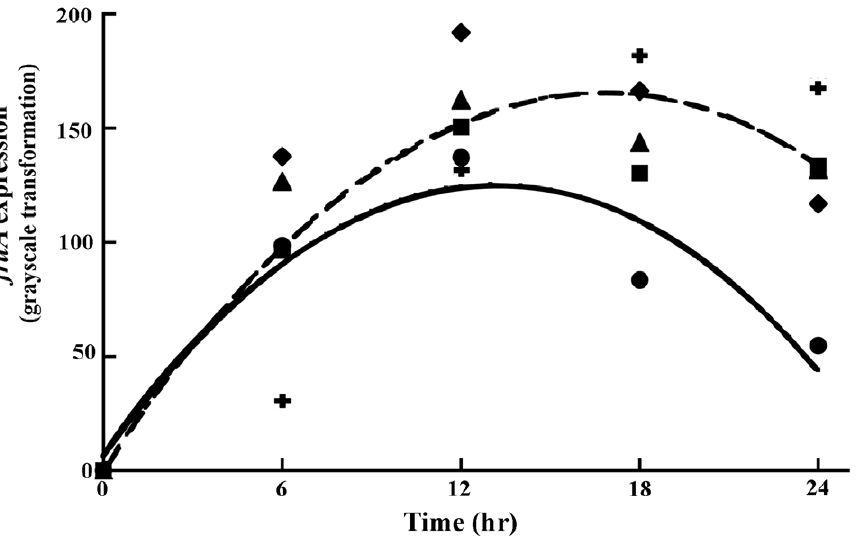
Figure 2. Expression of fruA over time for all strains. Code for strains are: DZF1 (circle), A2 (square), C2 (cross), D1 (triangle), and D9 (diamond). Solid and dashed lines correspond to the parental and knock-out mutant strains respectively.